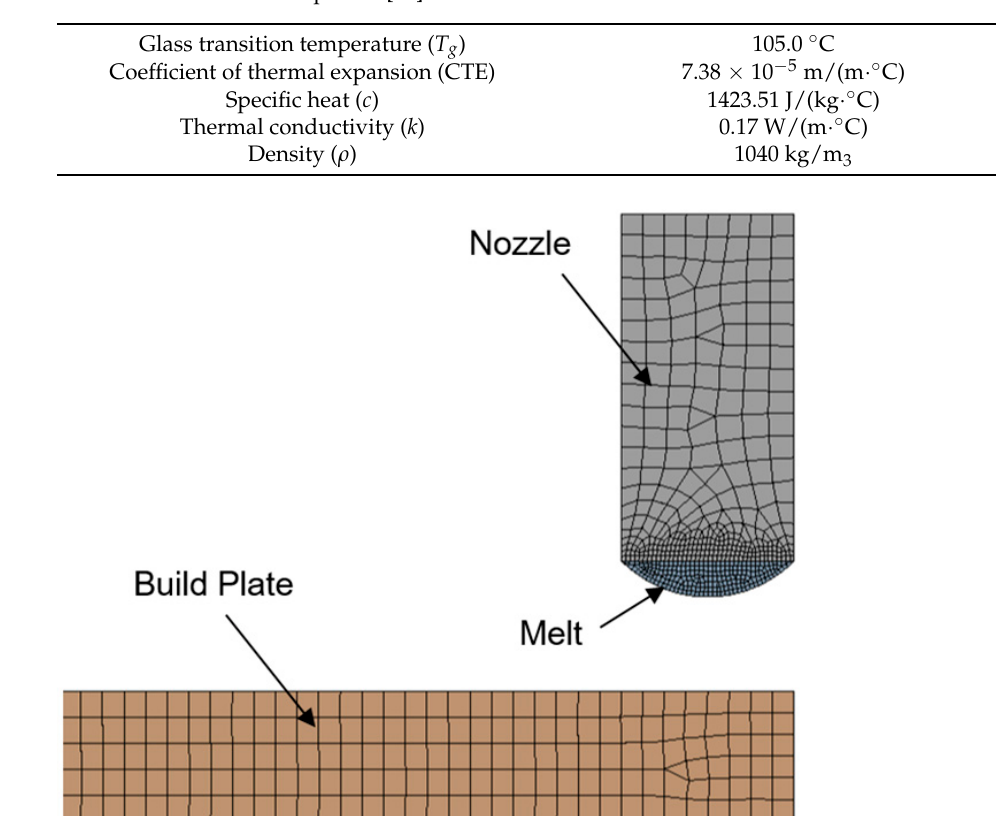
Figure 6. Initial element size distribution of the build plate, the nozzle, and the melt.